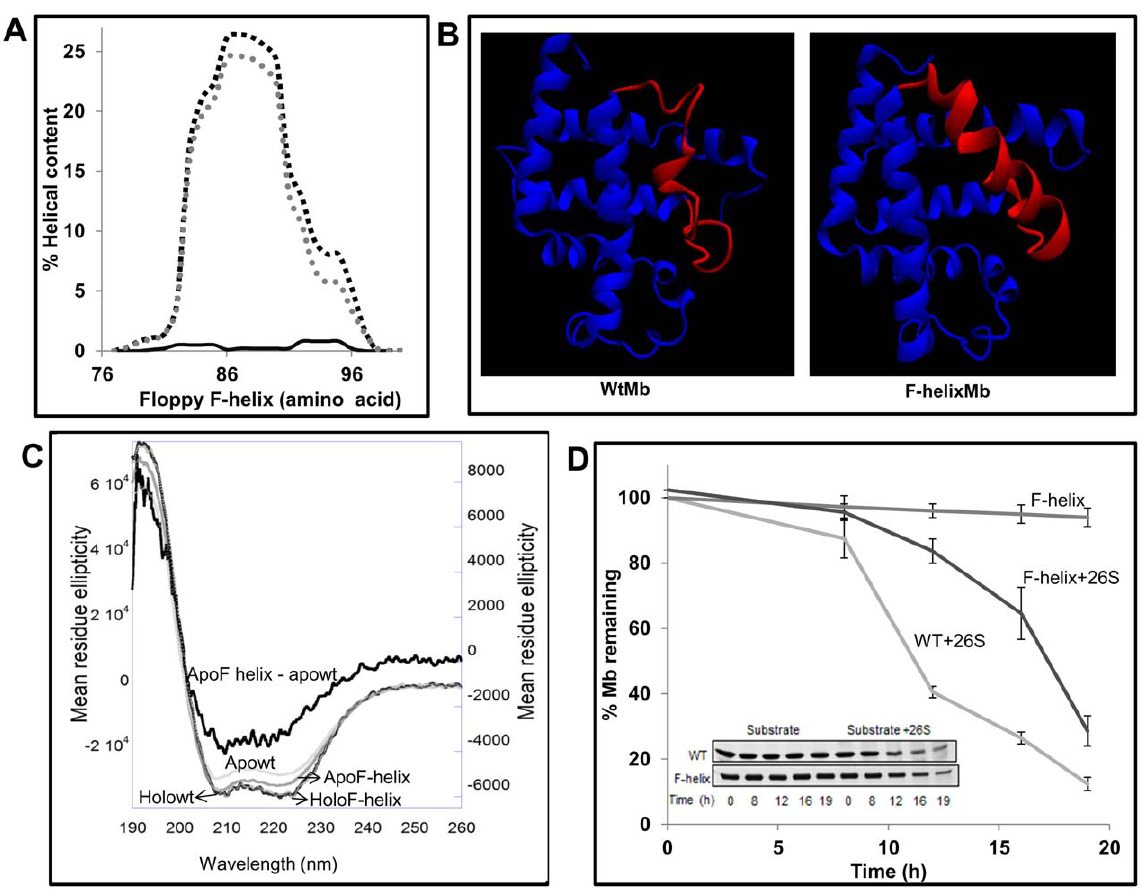
Figure 3. Floppy F-helix is crucial for the degradation of ApoMb. (A) AGADIR prediction (parameter, pH 7.5, Temperature 273K, Ionic strength 0.15 M) of the helical propensity of floppy F-helix. Wt sequence (solid line), G80AP88AS92AH97E (dashed grey) and G80AP88AS92AH97N (dashed black). (B) MD simulation of wt apoMb and the F-helix mutant. The wt sequence melts immediately at 400 K while the F-helix mutant remains stable even at the end of 2.8 ns simulation. (C) To verify the role of floppy F-helix exposed upon removal of heme, helix stabilizing mutations were introduced. Far-UV CD spectrum shows that the Apo F-helix mutant has enhanced secondary structure as compared to the wt ApoMb. The difference spectra were obtained by subtracting the spectra of apowt from apoF-helix (MRE values are on Y2). (D) Apo wt and apo F-helix proteins were incubated with proteasome. The rate of degradation was followed by SDS-PAGE (inset) and quantified as described in methods. Data represent the mean values 6 S.D of at least three independent experiments for wt apoMb and five independent experiments for F-helix mutant. Remarkably, stabilization of F-helix rendered ApoMb more resistant to degradation by the proteasome.